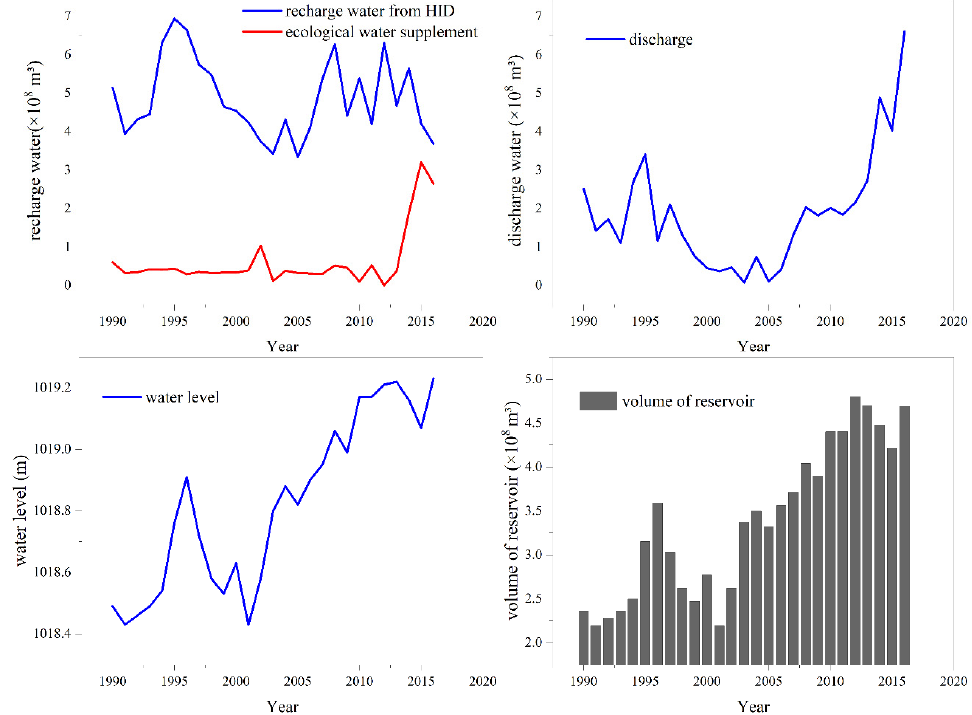
Figure 3. Analysis of water supply and displacement of the lake through channels and schematic diagram of water level storage capacity change.